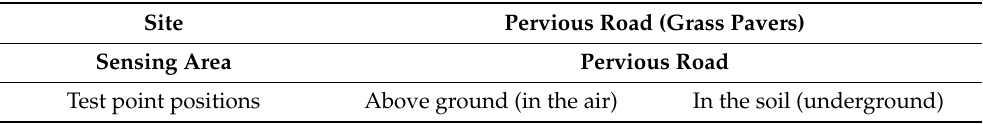
Figure 4. The sensing positions on the pervious road: ( a ) photograph and ( b ) schematic. Table 3. Sensing positions on the pervious road.